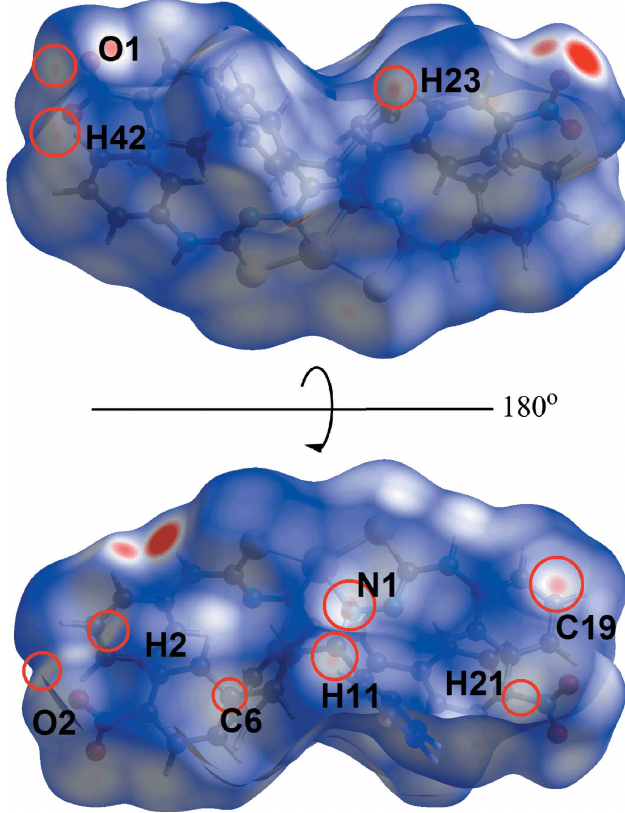
Figure 5 View of the Hirshfeld surface mapped over d norm for (I), highlighting inter-chain C—H (cid:3)(cid:3)(cid:3) O and C—H (cid:3)(cid:3)(cid:3) C interactions.